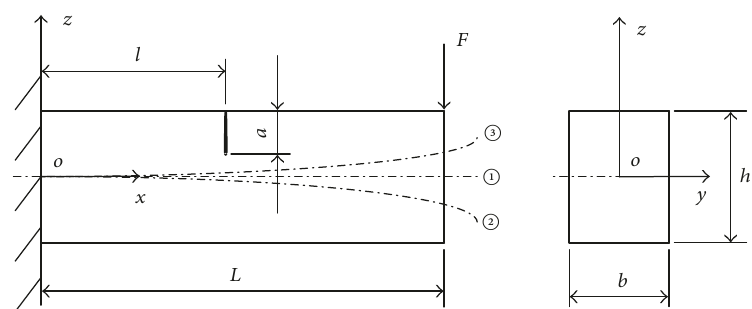
Figure 1: Model of a cracked cantilever beam, where 𝐹 is an exciting force and 𝑎 is the crack